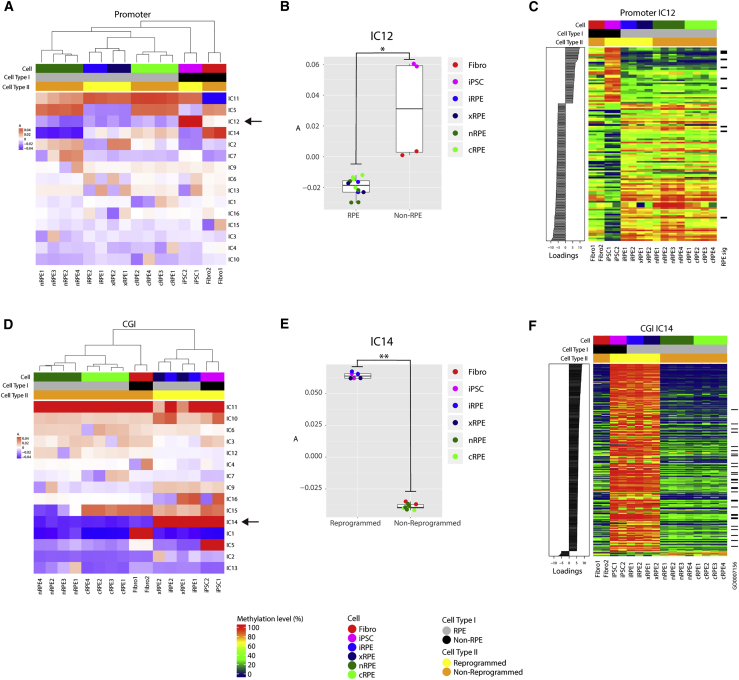
Genomic Feature-Dependent Differential Clustering of iRPE Methylome(A) ICA-based clustering using the methylation levels of promoters. The color scale indicates element values of the mixing matrix A of ICA (Hyvarinen and Oja, 2000). The columns of A are used for clustering of samples. Note that the nearest neighbor of iRPE/xRPE is cRPE. The arrow indicates the row of A corresponding to IC12.(B) Differential weighting of IC12 between RPE and non-RPE cells. Element values in the row of A corresponding to IC12 are plotted for individual samples (∗p < 0.01 by Wilcoxon test).(C) Methylation heatmap of promoters with significant contributions to IC12 (absolute value of loadings ≥5). Promoters of RPE signature genes are indicated on the right of the heatmap (RPE sig).(D) ICA-based clustering using the methylation levels of CGIs. The color scale indicates element values in the mixing matrix A of ICA (Hyvarinen and Oja, 2000). The columns of A are used for clustering of samples. Note that the nearest-neighbor of iRPE/xRPE is iPSC. The arrow indicates the row of A corresponding to IC14.(E) Differential weighting of IC14 between reprogrammed and non-reprogrammed cells. Element values in the row of A corresponding to IC14 are plotted for individual samples (∗∗p < 0.001 by Wilcoxon test).(F) Methylation heatmap of CGIs with significant contributions to IC14 (absolute value of loadings ≥5). CGIs proximal to genes involved in “homophilic cell adhesion via plasma membrane adhesion molecules” are indicated on the right of heatmap (GO: 0007156).